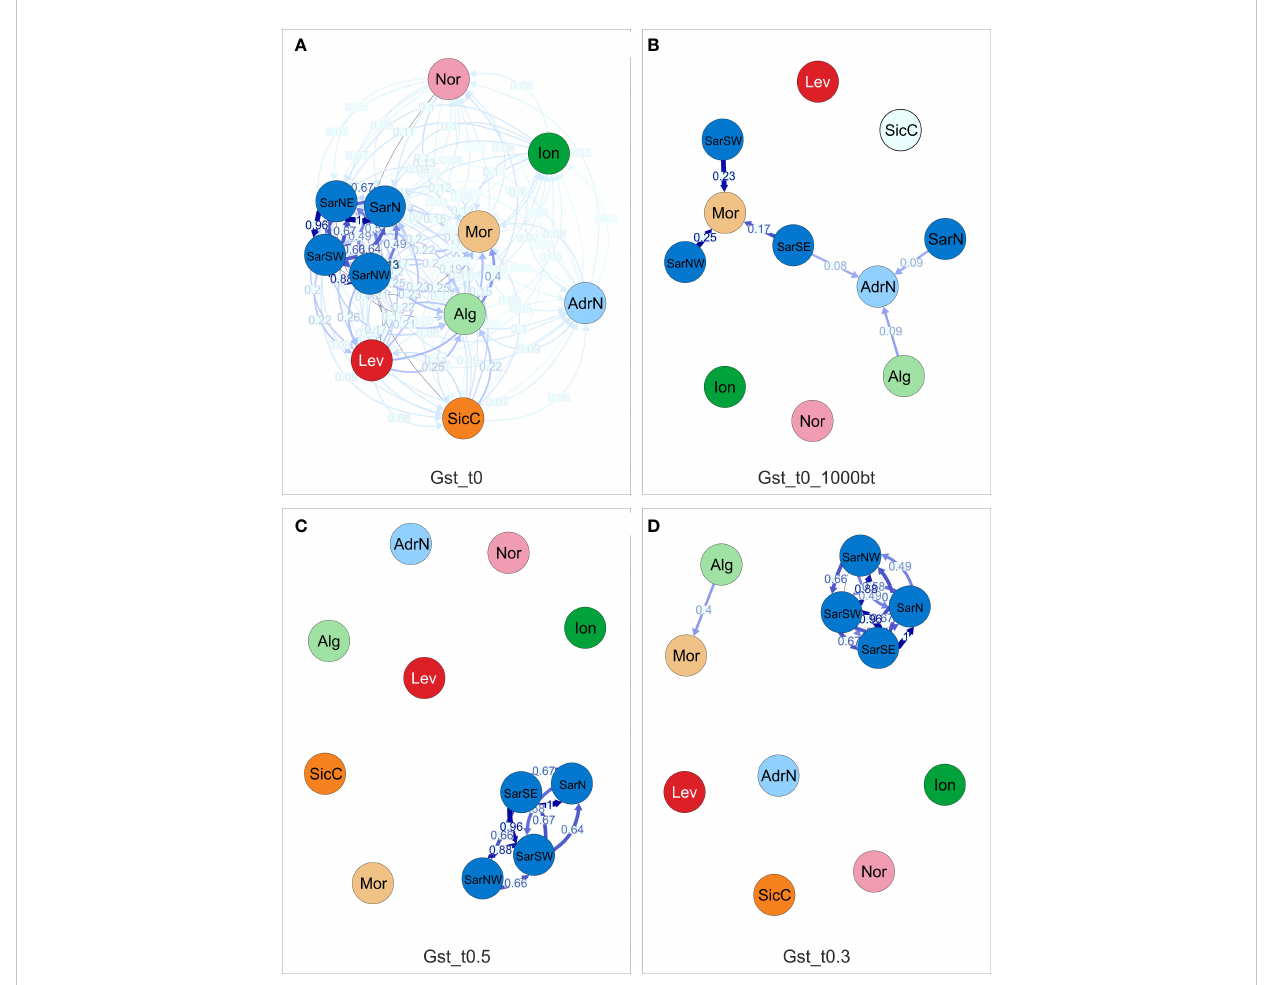
FIGURE 4 Directional relative migration network for Scyliorhinus canicula populations based on the Gst distance calculated with DivMigrate. (A) illustrates the calculated migration values, (B) includes only the values found to be asymmetric, that is they are statistically higher in the shown direction after 10,000 bootstrap replicates. The fi lter threshold for the asymmetric values was set to 0.5 in (C) and 0.3 in (D) . Abbreviations are in accordance with Figure